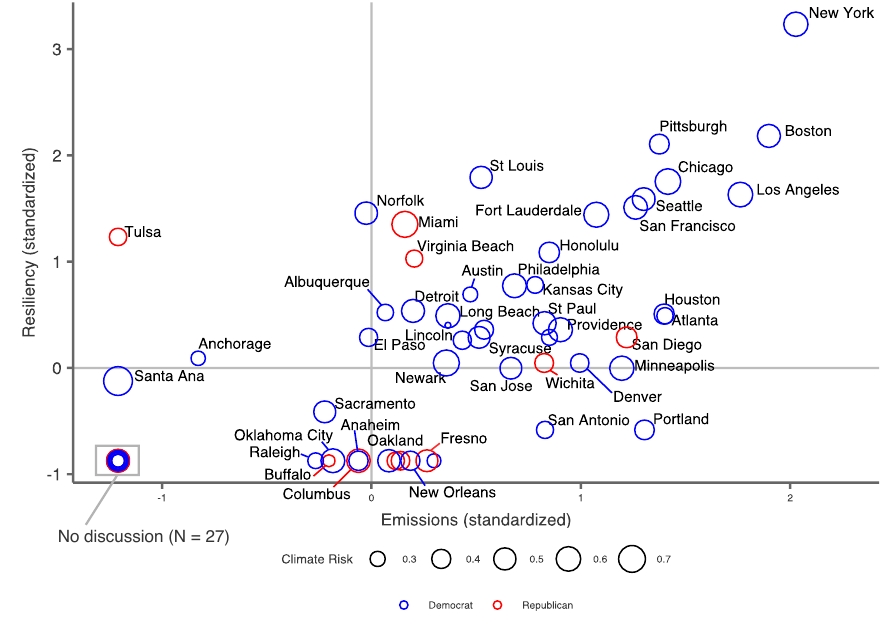
Figure 3. Reducing GHG emissions versus promoting climate resiliency. The figure presents standardized ( z -scores) word totals assigned to climate Emissions ( x -axis) and Climate resiliency ( y -axis). Prior to standardization, word totals were transformed using ln ( 1 + x ) , given the presence of heavy-tailed word assignment distributions for both topics. Marker size indicates level of climate risk [43]. Republican mayors are in red, while Democratic mayors are in blue